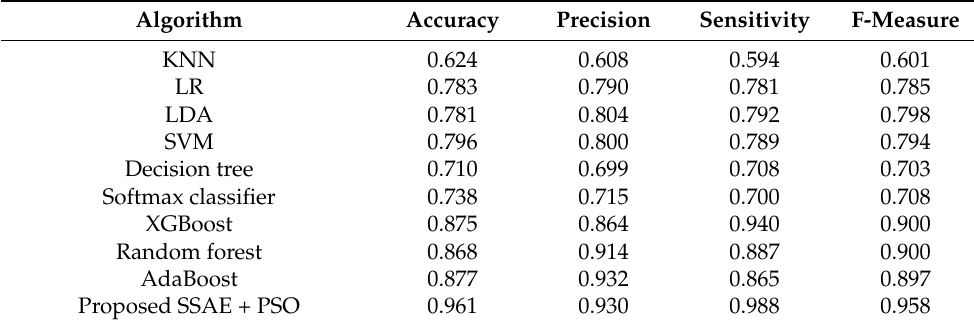
Table 4. Assessment of the performance of the algorithms using the Cleveland dataset.